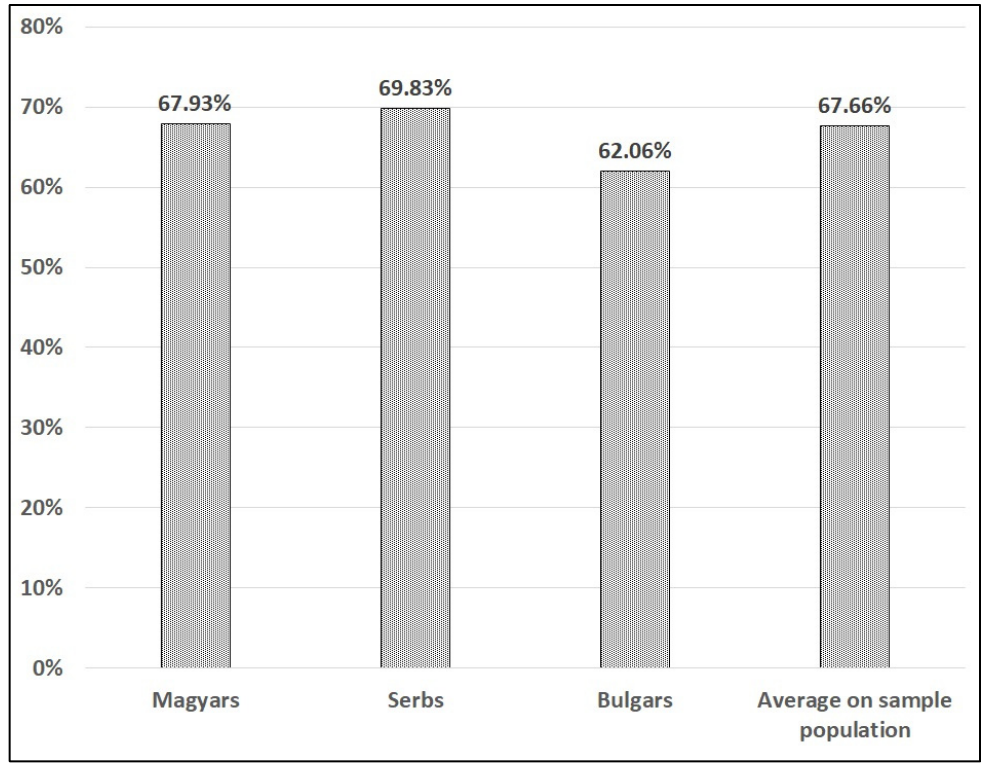
Figure 3. Percentage of respondents who have members of another ethnicity in their extended fam- ily.